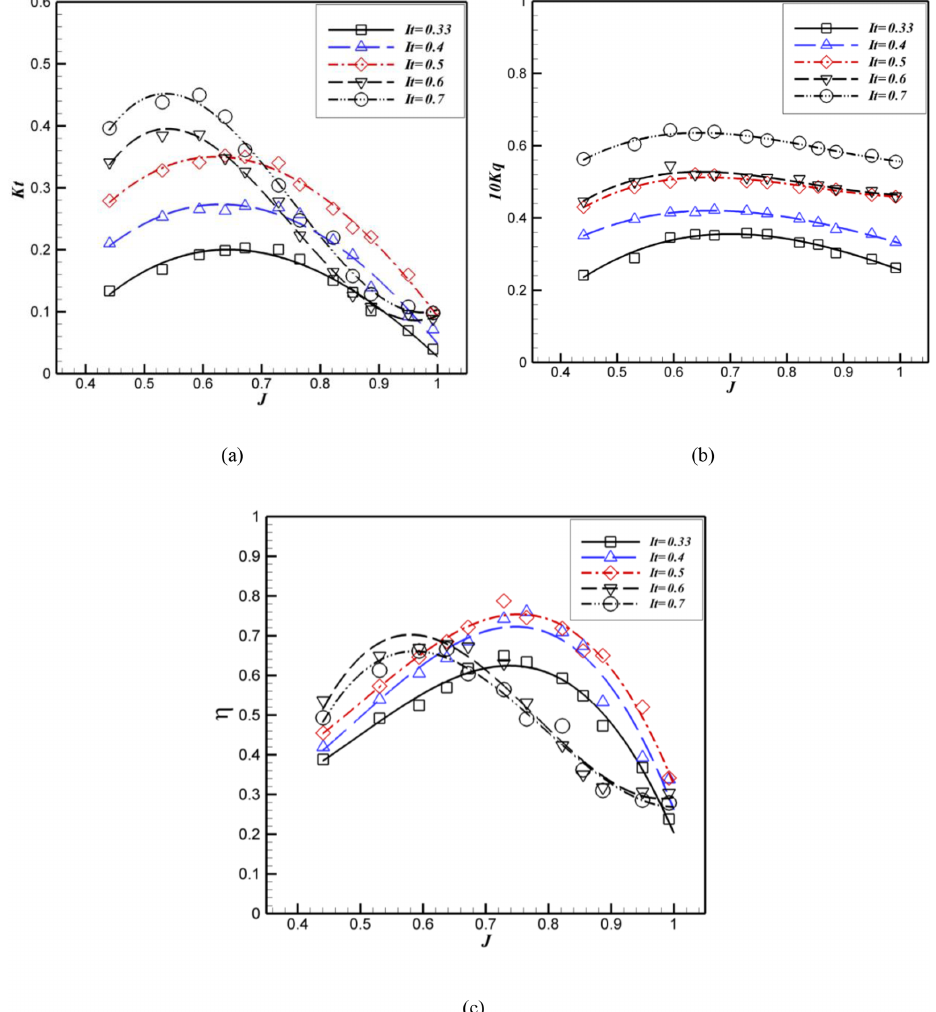
Figure 12. Hydrodynamic coefficients and efficiency of a surface-piercing propeller for a 0 shaft degree and different immersion